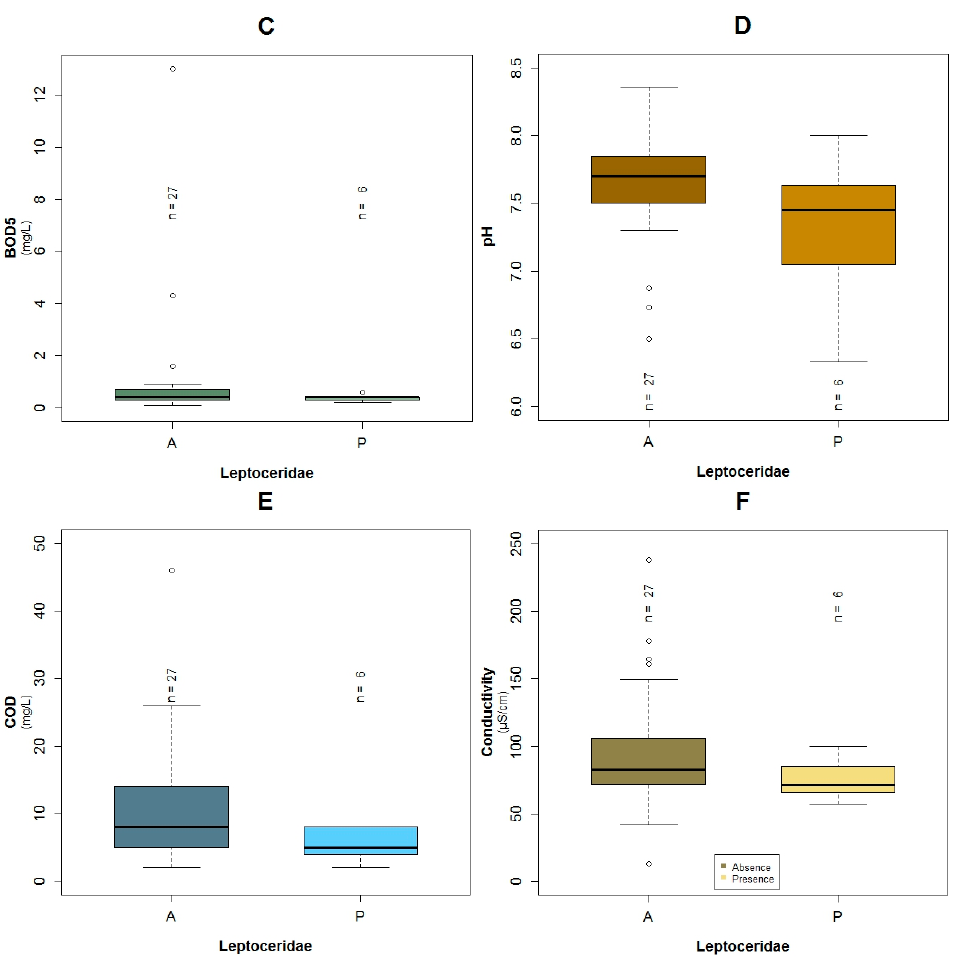
Figure A7. Boxplots showing the presence or absence of Leptoceridae with its explanatory variables ( A ) fecal coliforms expressed in log scale; ( B ) flow velocity; ( C ) BOD 5 ; ( D ) pH; ( E ) COD and ( F ) conductivity.